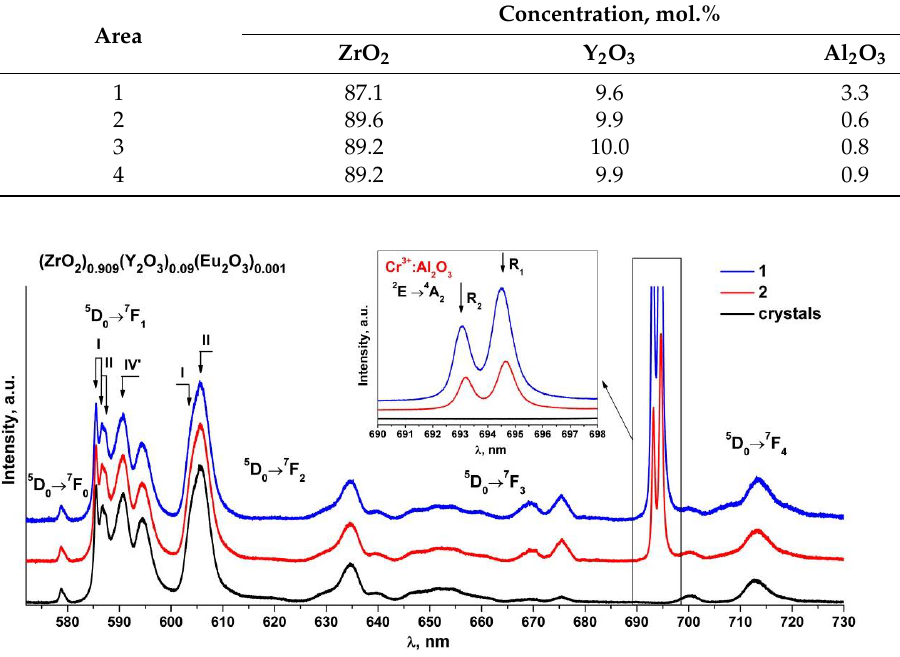
Figure 6. Luminescence spectra of (ZrO 2 ) 0.909 (Y 2 O 3 ) 0.09 (Eu 2 O 3 ) 0.001 single crystal and ceramic solid solutions synthesized using different methods from crushed single crystals: (1) uniaxial compaction; (2) slip casting. λ = 532 nm, Т = 300 K. Inset: luminescence bands (R 1 and R 2 ) of Cr 3+ ions in Al 2 O 3 for the 2 E → 4 A 2 transition. Analysis of the luminescence spectra for the transitions between the 5 D 0 and 7 F J ( 0-4 ) multiplets of the Eu 3+ ions in the (ZrO 2 ) 0.909 (Y 2 O 3 ) 0.09 (Eu 2 O 3 ) 0.001 ceramic solid solutions rec- orded with excitation of the 5 D 1 level of the Eu 3+ ions by a 532 nm laser at T = 300 K shows that they contain the same spectral bands as the respective spectra of the (ZrO 2 ) 0.909 (Y 2 O 3 ) 0.09 (Eu 2 O 3 ) 0.001 single crystal solid solutions. The luminescence spectra of the (ZrO 2 ) 0.909 (Y 2 O 3 ) 0.09 (Eu 2 O 3 ) 0.001 single crystals for the 5 D 0 → 7 F 0-2 transitions of the Eu 3+